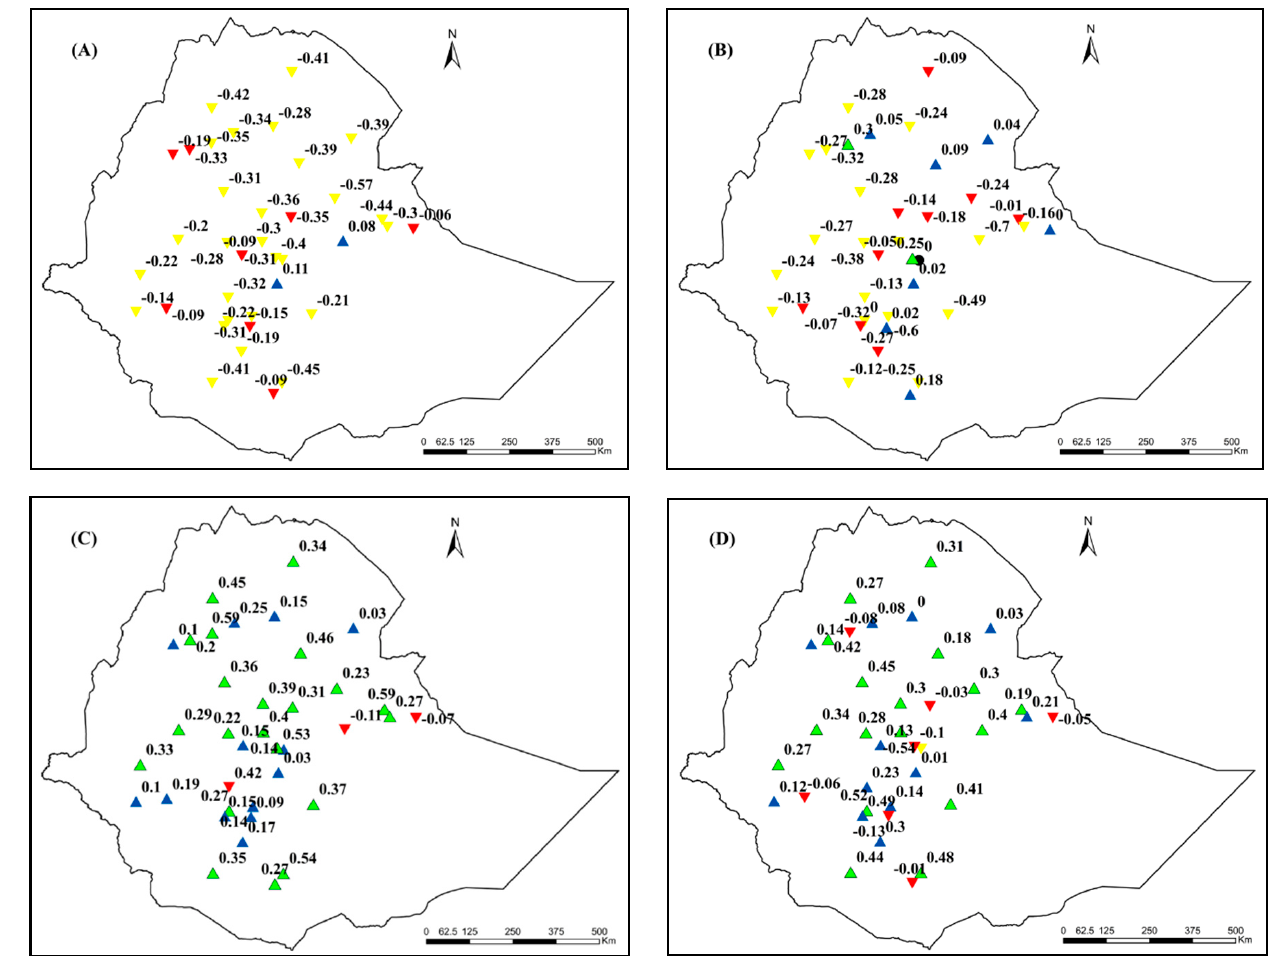
Figure 8. Spatial distributions of trends of the extreme temperature indices over Ethiopia for the long-term period between 1986 and 2020: ( A ) TX10p, ( B ) TN10p, ( C ) TX90p, and ( D ) TN90p. Note: Filled blue upright and filled red inverted triangle indicate increasing and decreasing trends, respectively, while circle black filled indicates no trend. Significantly increasing and decreasing trends are symbolized by a filled green upright triangle and a filled yellow inverted triangle, respectively. Insignificant trends are represented by filled upright and inverted triangles.